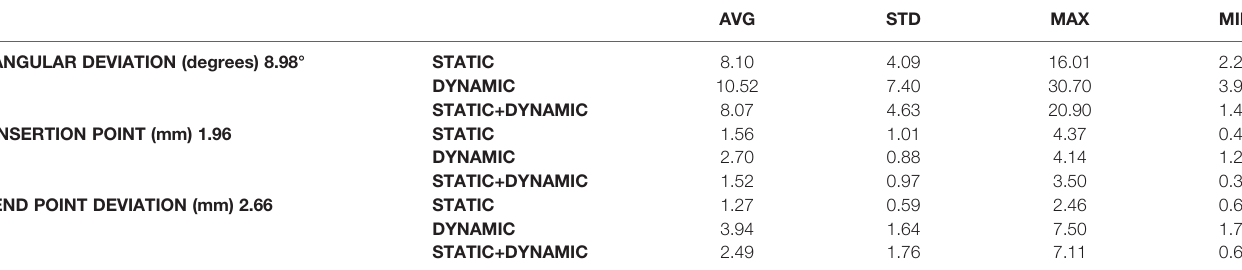
TABLE 5 | Average, standard deviation and maximum and minimum values of the results for angular deviation, insertion point deviation, and end point deviation.